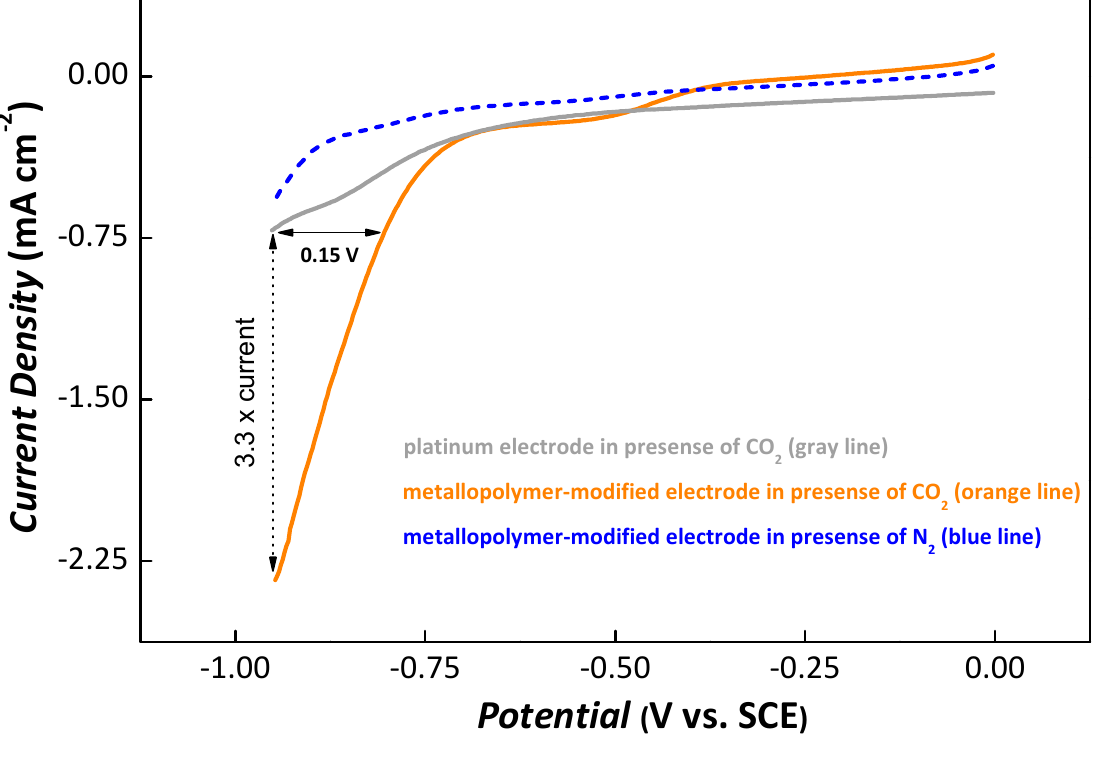
Figure 4. Cathodic linear sweep voltammetry of the poly-Pd(salen) (orange line) and platinum elec- trode (gray line) in 0.50 mol L − 1 KCl solution saturated with CO 2 at a scan rate of 25 mV s − 1 . The blue dashed line represents the electrochemical response of the modified electrode in the absence of CO 2 . dioxide, the metallopolymer platform was tested in the absence of carbon dioxide (dashed curve of Figure 4). In the absence of carbon dioxide in the electrolytic solution, the metal- lopolymer-modified electrode showed two reduction peaks ( − 0.56 V and − 0.80 V) related to the transformation of Pd(II) to Pd(I) and Pd(I) to Pd(0), respectively. Under a carbon dioxide atmosphere (orange curve), the current increased significantly after a potential of − 0.70 V was applied, clearly indicating that the total reduction of the metal center drives the overall reduction of dissolved carbon dioxide.